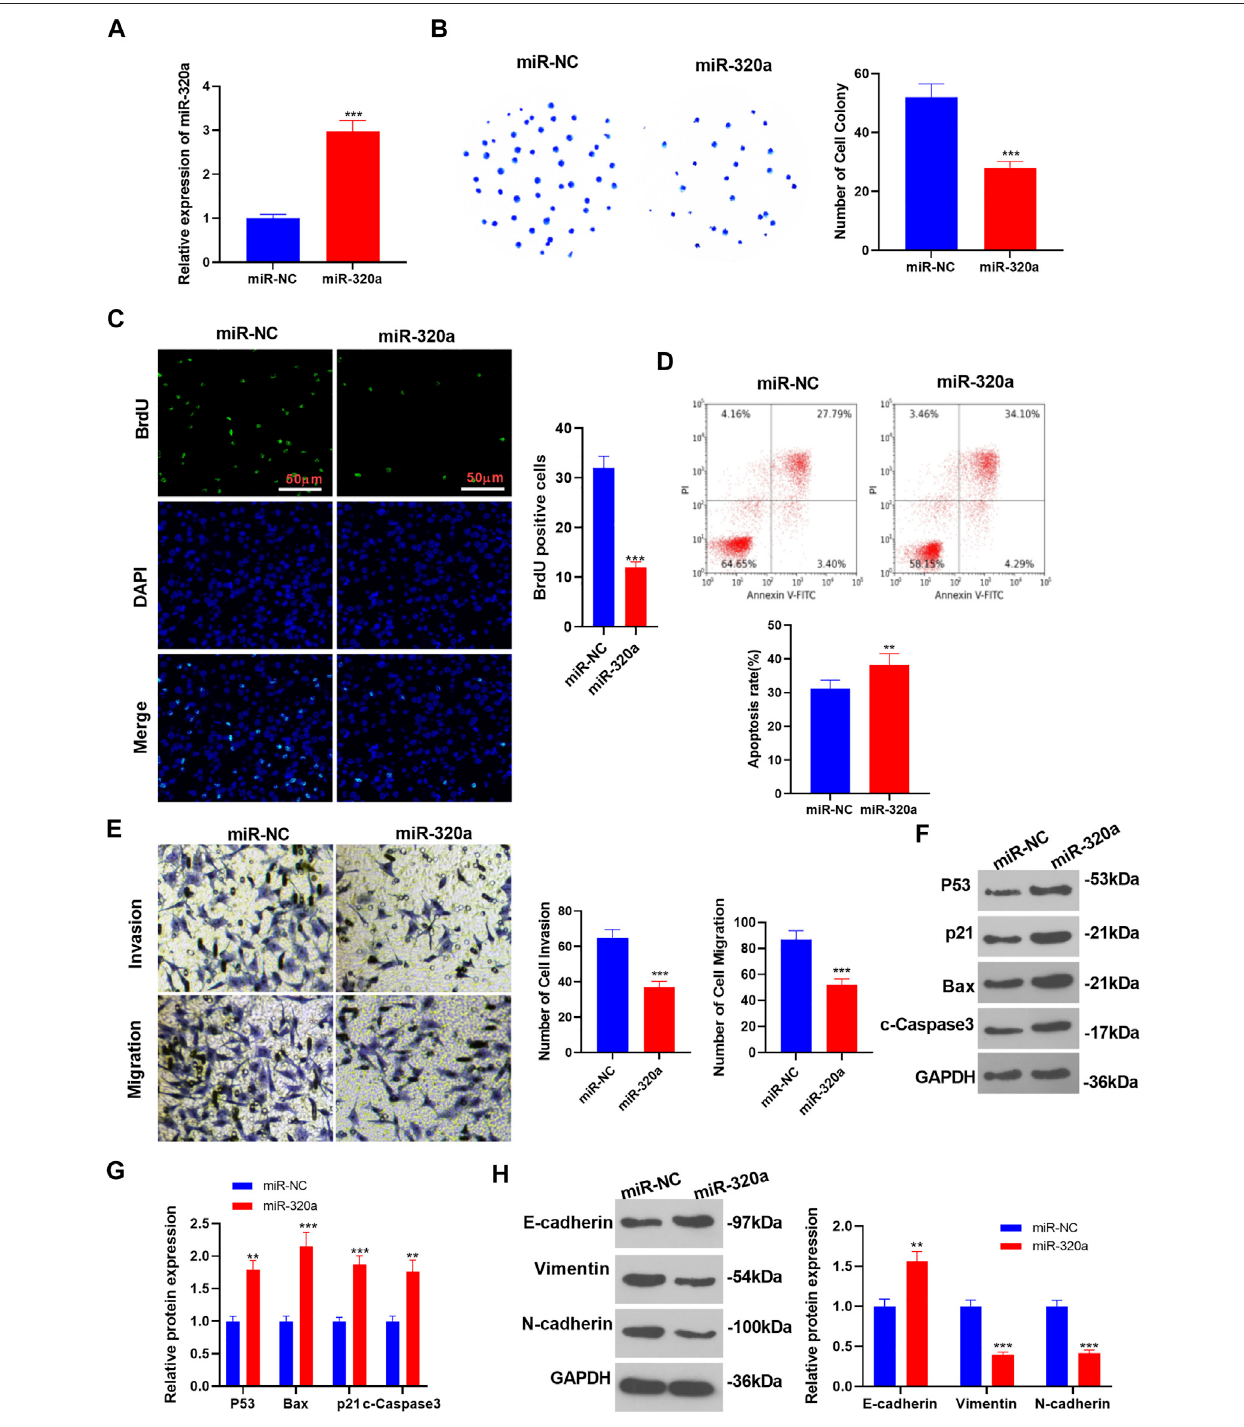
FIGURE 7 | In fl uences of miR-320a on the malignant phenotype in RCC. miR-320a mimics were transfected into A-498 cells. (A) : The miR-320 pro fi le was determined by RT-qPCR. (B – D) : RCC cell proliferation and apoptosis were checked by the colony formation assay, BrdU assay and fl ow cytometry, respectively. (E) : Transwell assay was implemented to verify RCC cell migration and invasion. (F – H) : WB was conducted to evaluate the expression of P53, Bax, p21, c-Caspase3, E-cadherin, Vimentin, and N-cadherin. ** p < 0.01, *** p < 0.001. N (cid:2) 3.